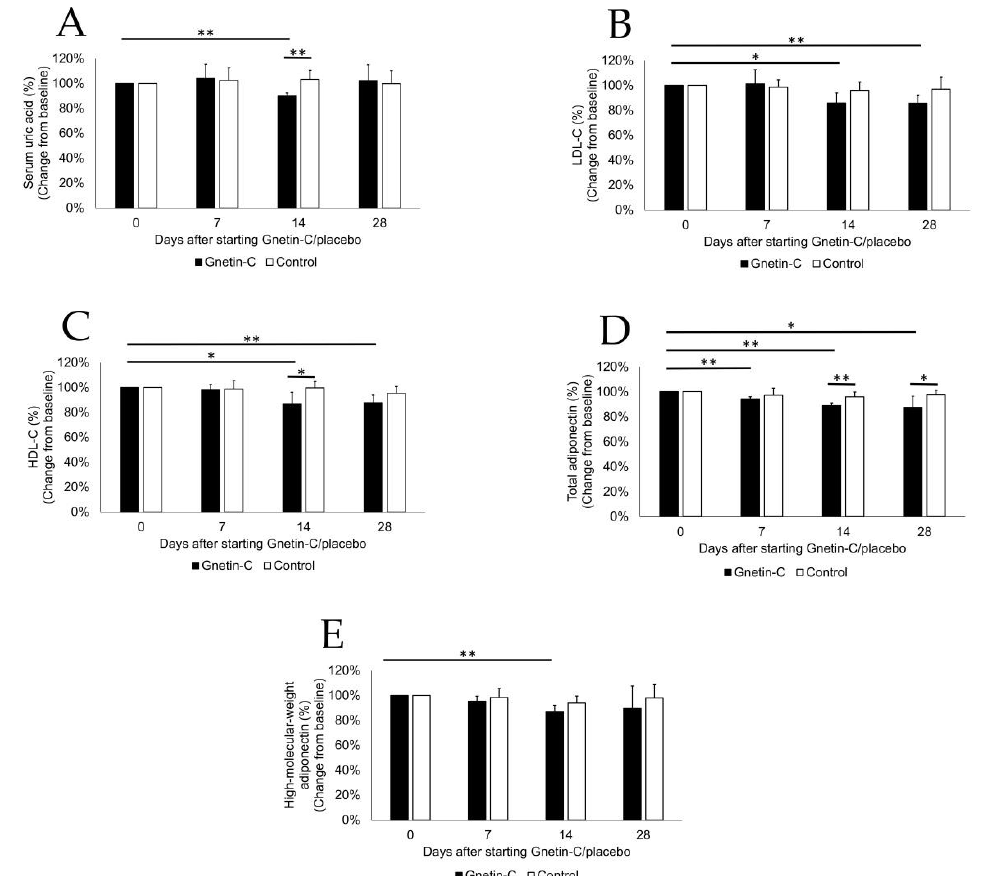
Figure 7. The e ff ects of Gnetin-C on biochemical test results and lipid profiles. ( A ) Serum levels of uric acid; ( B ) low-density lipoprotein cholesterol (LDL-C); ( C ) high-density lipoprotein cholesterol (HDL-C); ( D ) total adiponectin, and ( E ) high-molecular-weight (HMW) adiponectin before and after the intervention in Gnetin-C and placebo groups. * p < 0.05; ** p < 0.01.